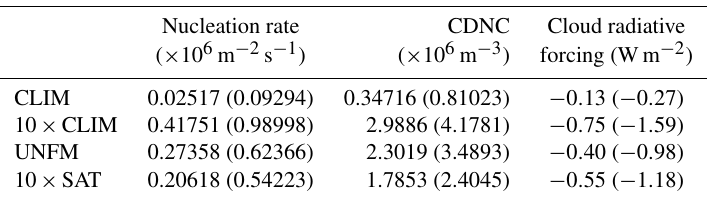
Figure 6. Change in cloud droplet number concentration at the first model level above the surface due to Arctic DMS emissions (relative to CNTRL). Stippling represents change significant at the 95% confidence level. Zonal mean results are shown in the bottom panel. Table 2. Arctic mean aerosol nucleation rate, CDNC, and cloud radiative forcing in 2000 (2050) associated with emissions of DMS in the